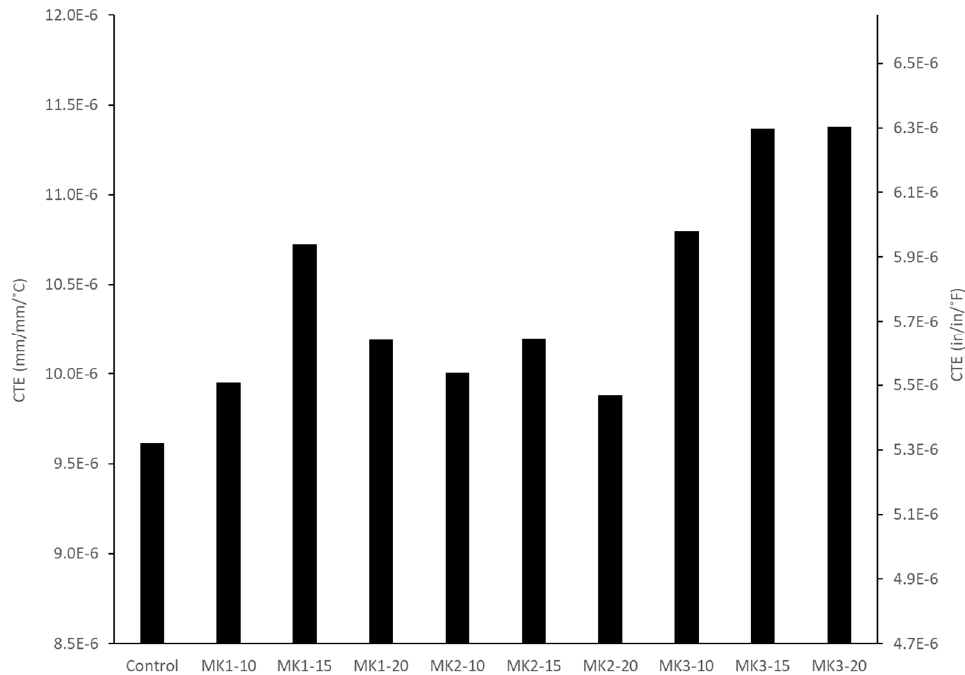
Figure 9. Thermal behavior of metakaolin concretes represented as their coefficients of thermal expansion.